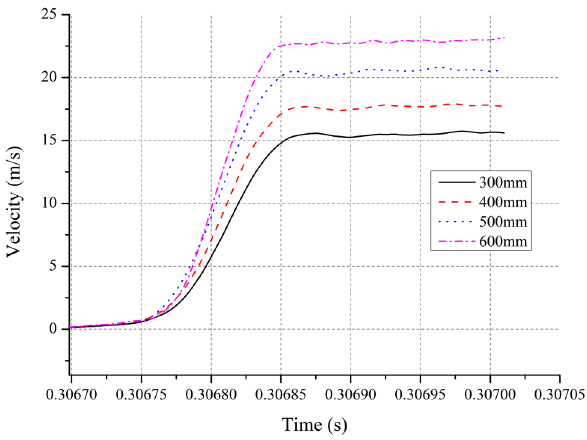
Figure 5. Velocity–time curves of